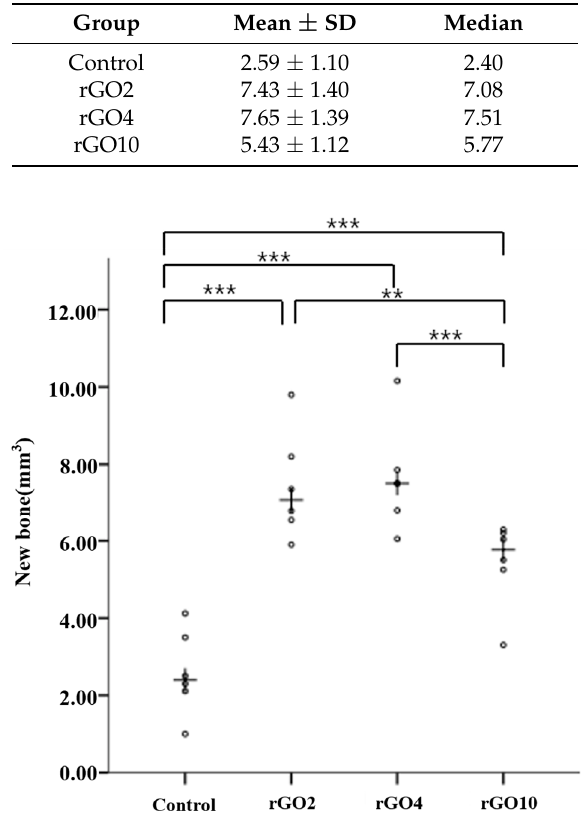
Figure 6. Scatter plot and median values (the crosses) of new bone volumes (mm 3 ) (** p < 0.01, *** p < 0.001).